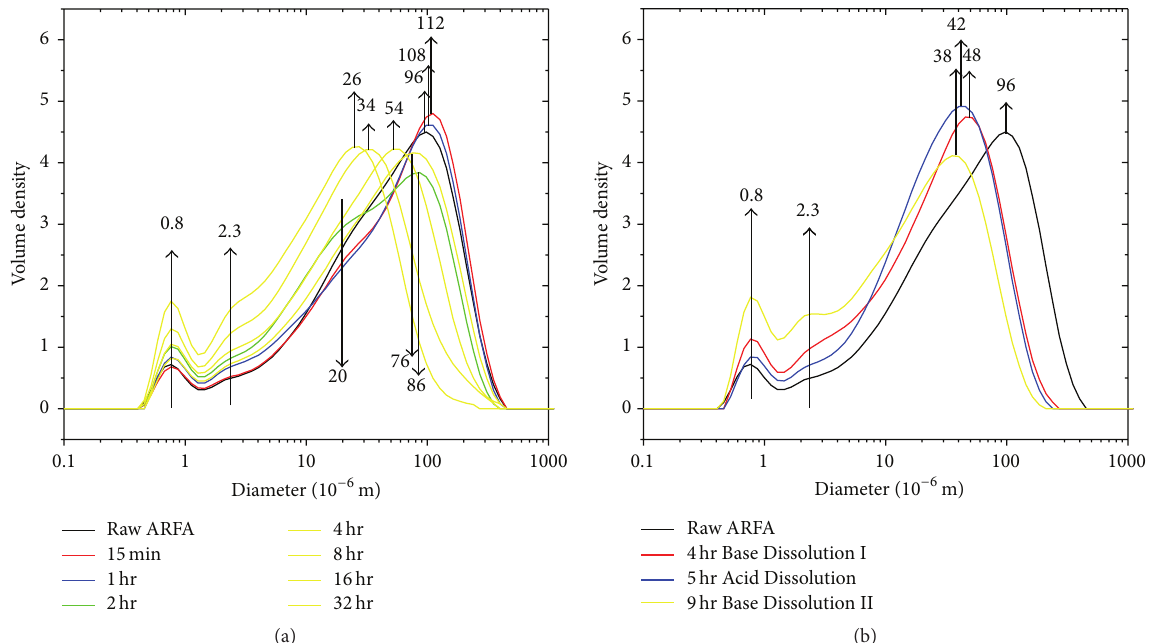
Figure 7: Particle transformations in acid (a) and base (b) digestion